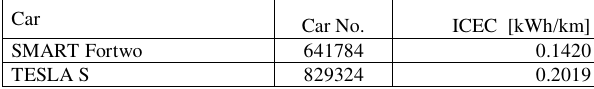
Table 2. Results of the analysis of variance to determine the adequacy of the model (6). Fig. 4. Energy footprint of TESLA S car No. 829324 Table 3. Intensity of cumulative energy consumption data for analyzed car Car Car No.